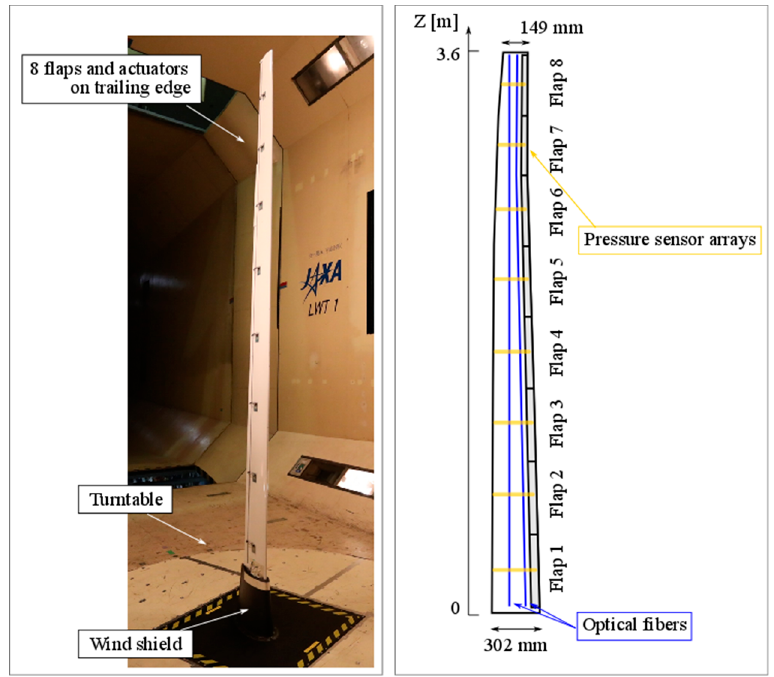
Figure 1. Wing model. Left : Photograph in wind tunnel taken from upstream and lower side of wing. Right : Schematic of flaps and sensors viewed from upper side of wing.